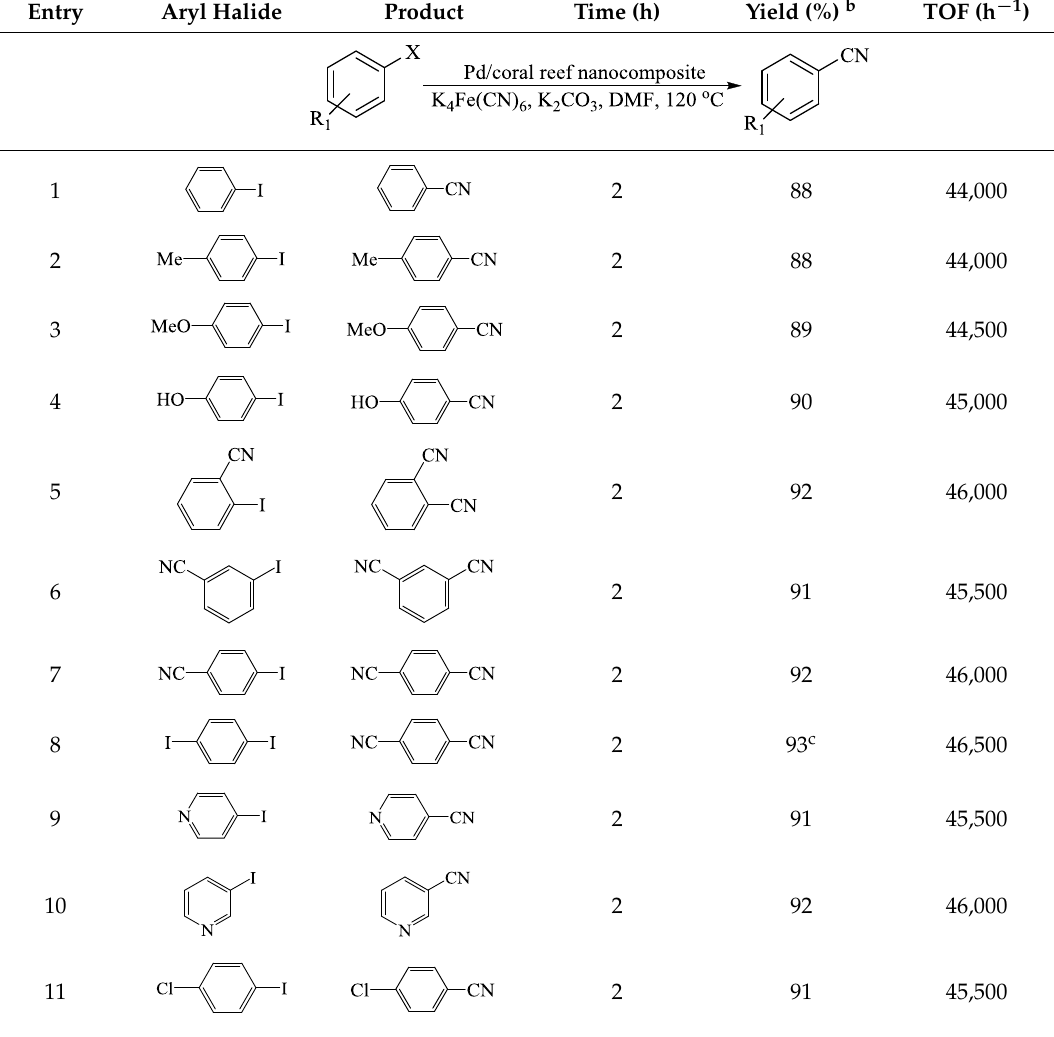
Table 2. Cyanation of aryl halides with K 4 Fe(CN) 6 in the presence of the Pd/coral reef nanocomposite a .